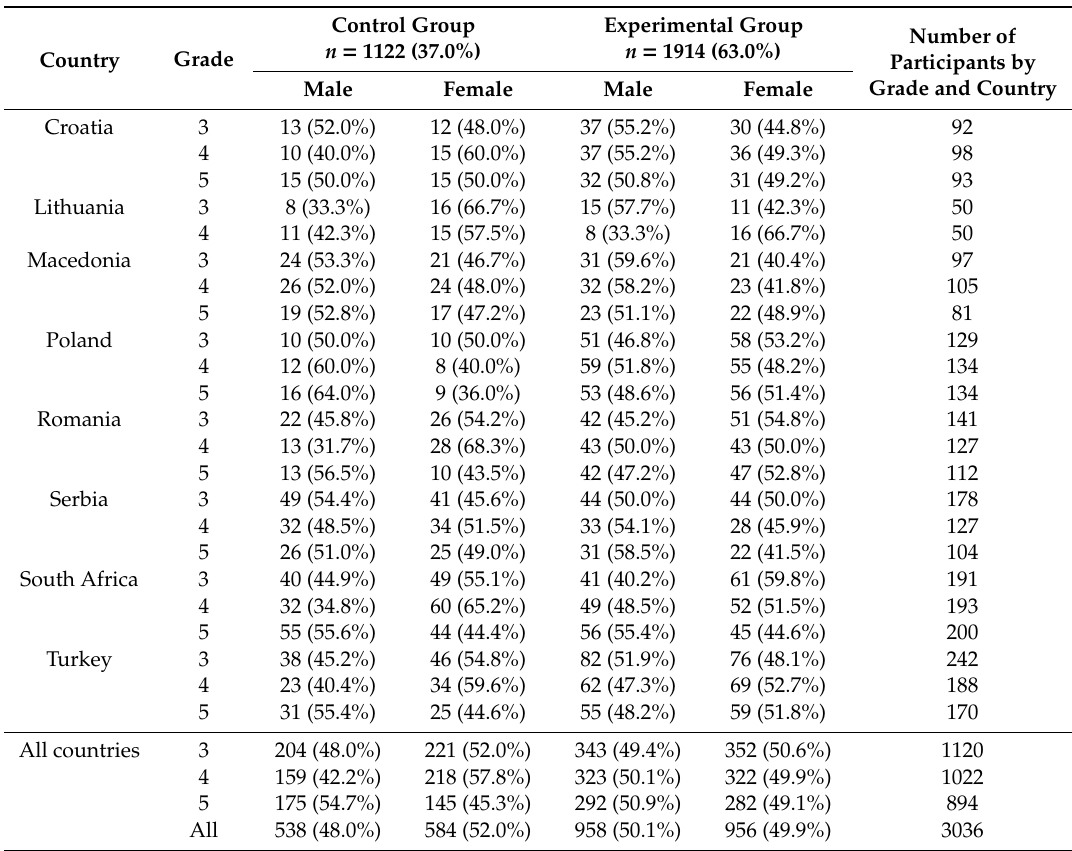
Table 2. General characteristics of the participants at pre-test ( N = 3036). a) Number of participants by gender, grade and country in the control and experimental